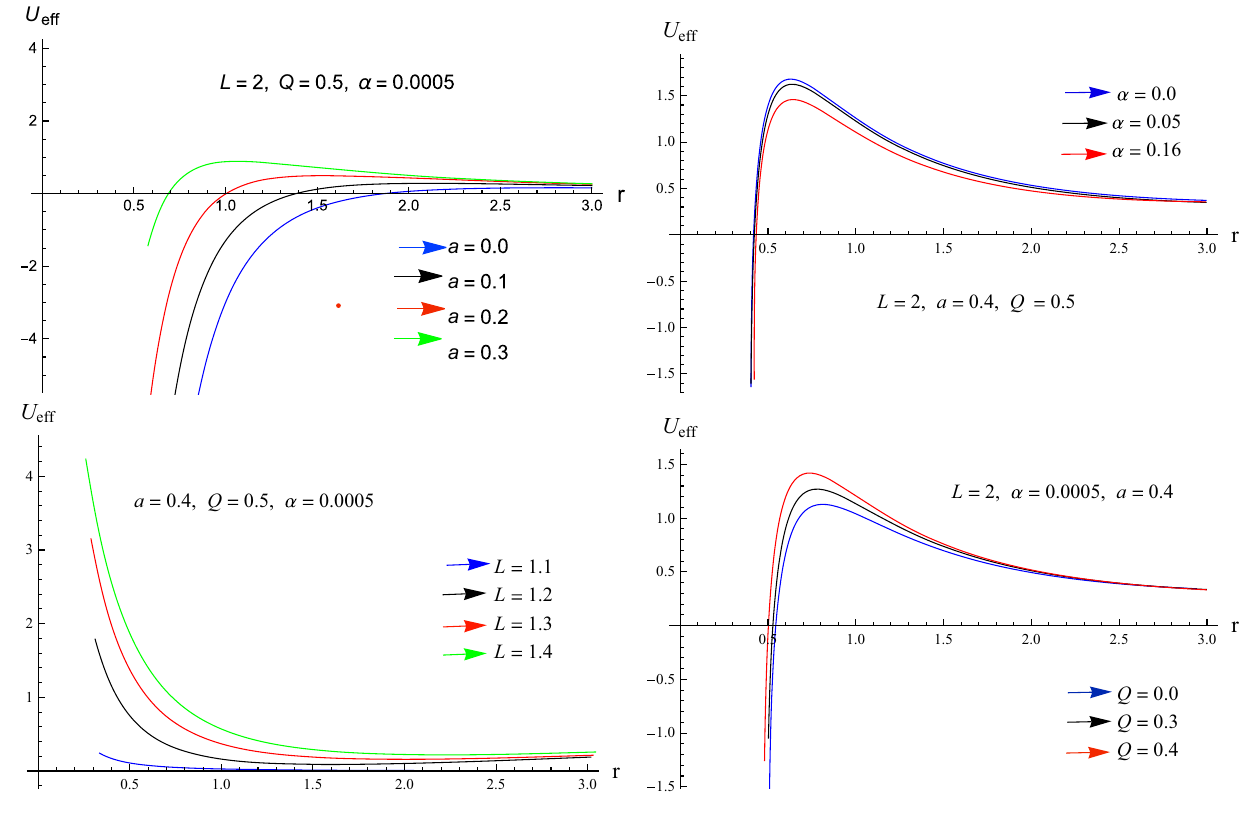
Fig. 3 Plots of effective potential for null geodesics as a of function of r for ω = − 2